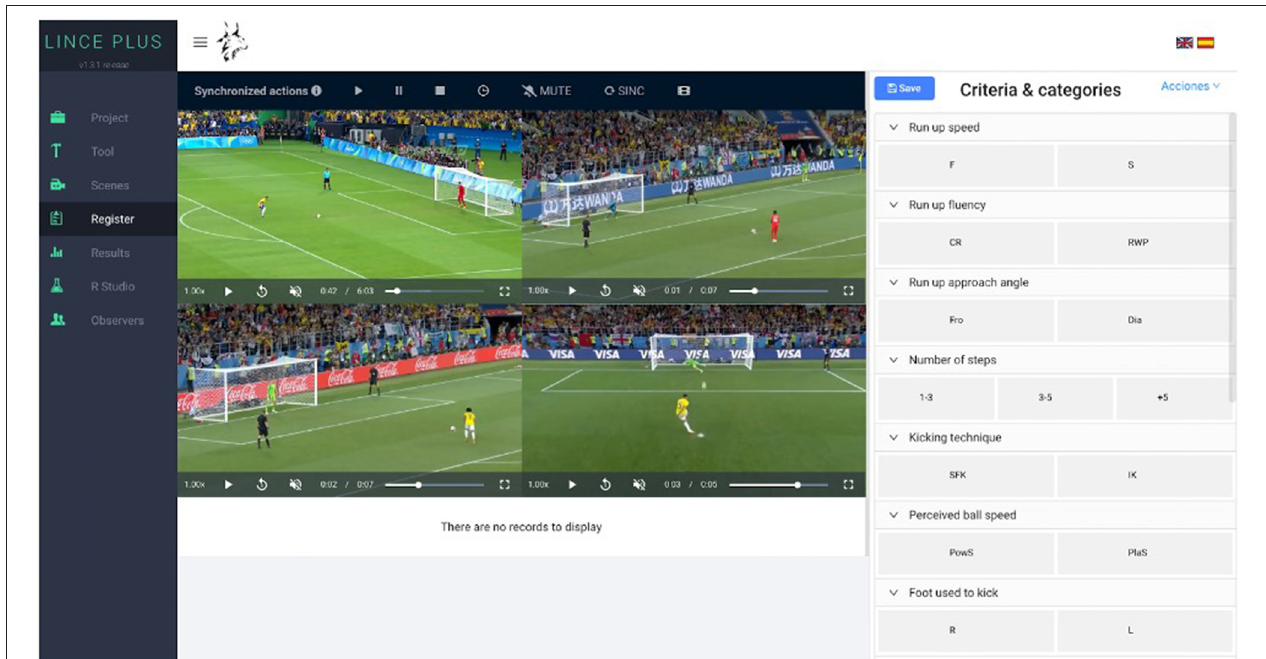
FIGURE 2 | Lince Plus interface. Example of criteria and categories